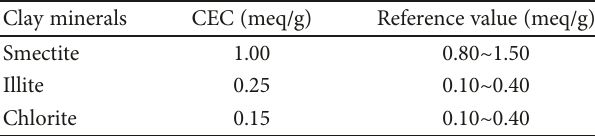
Table 2: Cation exchange capacity of di ff erent clay minerals. Clay